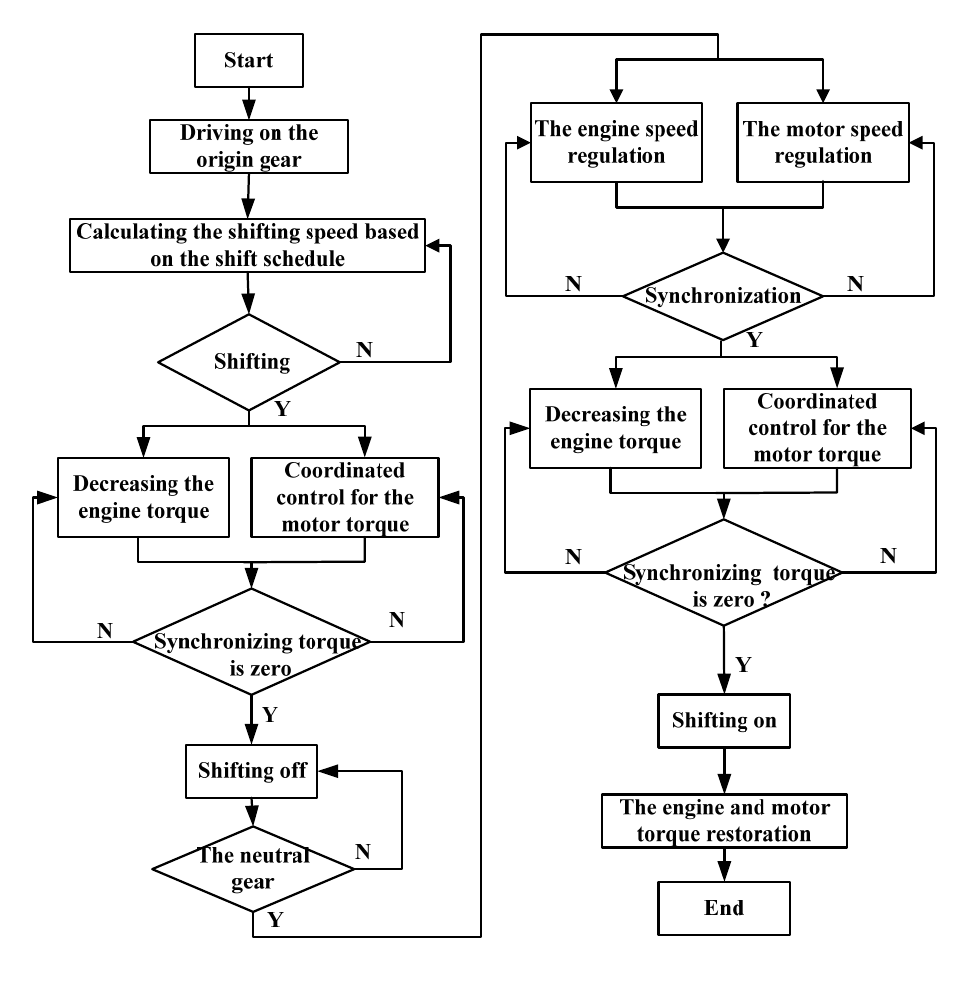
Figure 4. Flow chart of AMT shifting control without